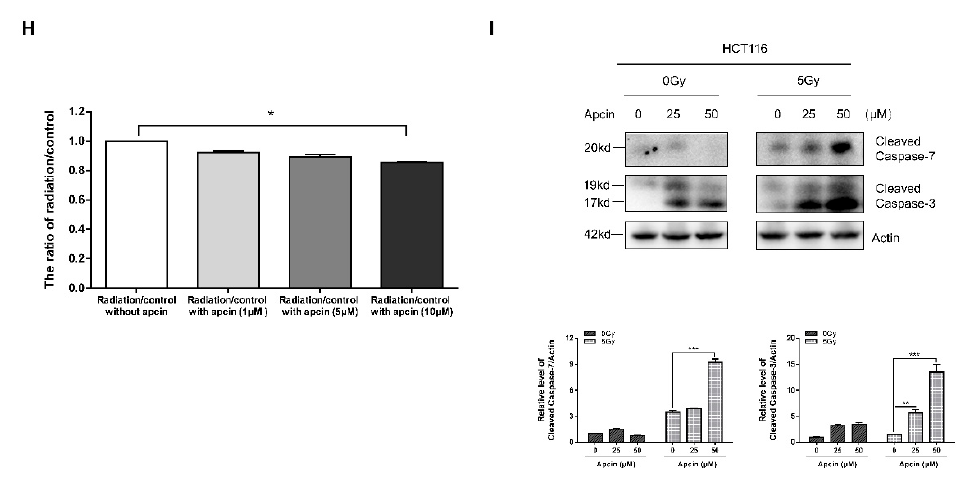
Figure 2. CDC20 attenuates the sensitivity of HCT116 cells to gamma-rays. ( A ) CDC20 was stably reduced in HCT116 cells by lentiviral infection. The expression levels of CDC20 were determined by immunoblotting analysis (sh-1 / 2 / 3 stands for three short hairpin RNA segments). ( B ) The expression levels of γ H2AX and Rad51 were detected by Western blotting in control and CDC20 knockdown cells at 24 h after 5 Gy gamma-ray irradiation. ( C ) The expression level of Rad51 was detected in control and CDC20 overexpression cells at 24 h after 5 Gy gamma-ray irradiation. ( D ) A clongenic assay of HCT116 cells with reduced CDC20 expression and control vector cells was carried out after irradiation with different doses of gamma-rays. ( E ) HCT116 cells with reduced CDC20 expression and control vector cells were exposed with the indicated doses of gamma-ray irradiation, and cell viability was measured 24 h later. ( F , G ) Higher expression level of apaf1, cleaved caspase-9, cleaved caspase-7, and cleaved caspase-3 ( F ) and more robust caspase-3 / 7 activation ( G ) were detected in CDC20 knockdown HCT116 cells compared with control vector cells 24 h after 5 Gy gamma-ray irradiation. ( H ) HCT116 cells were pretreated with different doses of apcin (0–10 µ M) for 24 h before 5 Gy gamma-ray irradiation, and cell viability was detected 24 h after irradiation. ( I ) Cells were preincubated with apcin (25 or 50 µ M) for 24 h before 5 Gy gamma-ray irradiation; then, the expression levels of cleaved caspase-7 and cleaved caspase-3 were determined by Western blot. Actin was used as an internal control. Data were pooled from three independent experiments and the results are represented as mean ± SD; * p < 0.05, ** p < 0.01, *** p < 0.001.